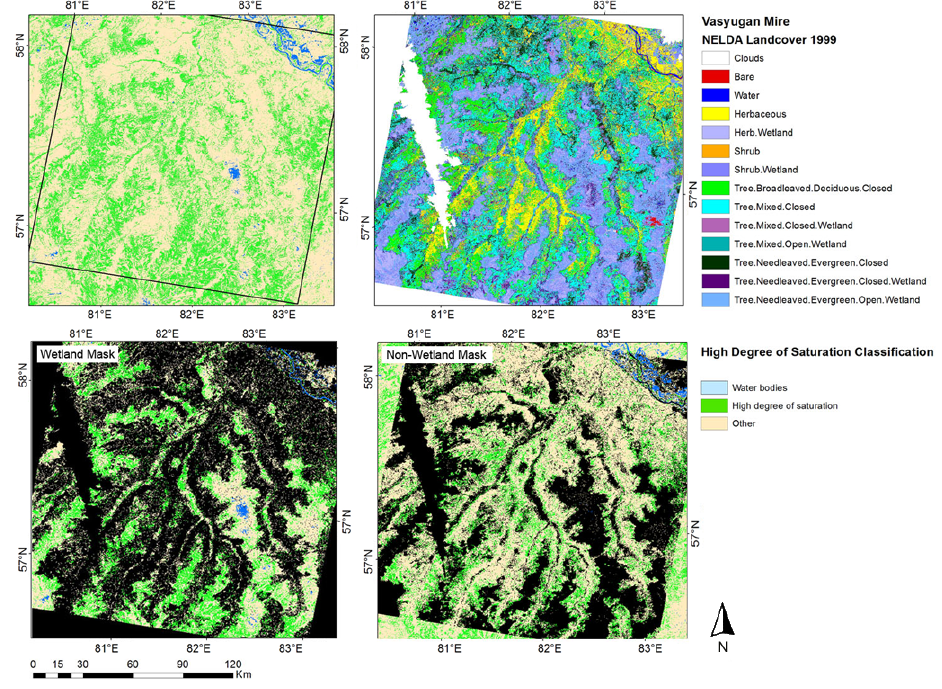
Figure 13. ( Upper left ): h S area classification of 2007.( Upper right ): Vasyugan W Mire classification of 1999. ( Lower left ): Mask of Vasyugan wetland classes [39] over h S classification. ( Lower right ): Mask of Vasyugan non-wetland classes over h S W classification.